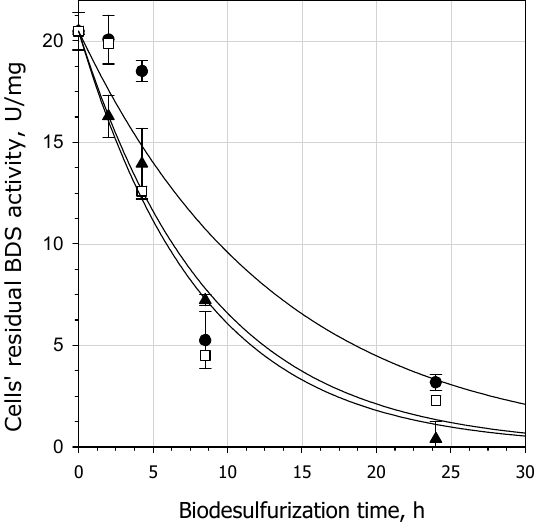
Figure 10. Time course of cells’ desulfurization activity during BDS of different concentrations of DBT. Symbols : 1.1 mM ( λ ), 2.6 mM ( π ), and 4.3 mM ( □ ). Solid lines represent fitting of the first-order exponential decay model.